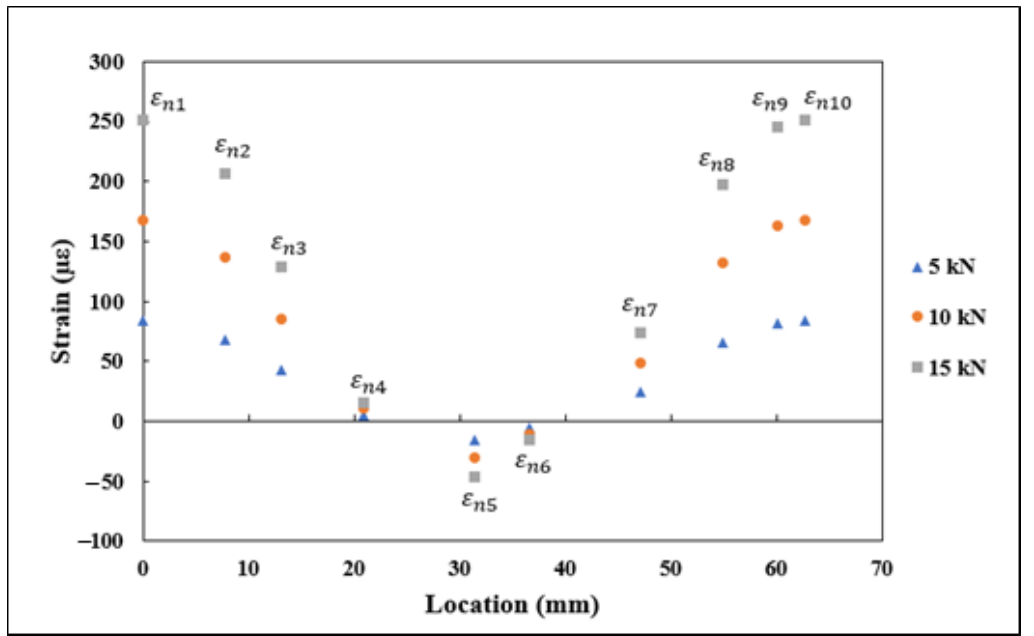
Figure 9. ε x 1 − ε x 10 , ε y 1 − ε y 10 , and γ xy 1 − γ xy 10 normal and shear strains obtained through FEA under tensile loading. Figure 9. 𝜀 𝑥1 − 𝜀 𝑥10 , 𝜀 𝑦1 − 𝜀 𝑦10 , and 𝛾 𝑥𝑦1 − 𝛾 𝑥𝑦10 normal and shear strains obtained through FEA under tensile loading.